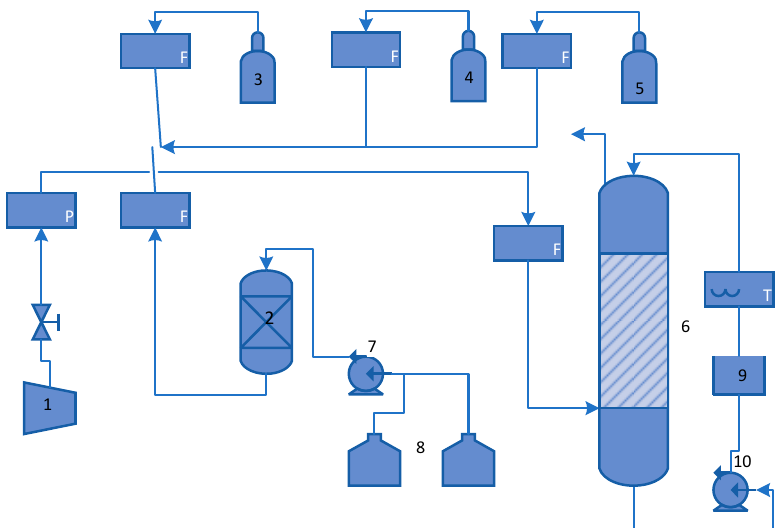
Figure 1. Experimental system for oxidation of sulfur compounds in the biotrickling filter. (1) Compressor; (2) H 2 S generator; (3) DMDS generator; (4) MM cylinder; (5) DMS generator; (6)